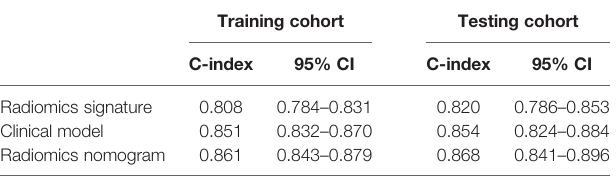
TABLE 2 | The C-index with 95% con fi dence intervals calculated for the training and validation cohorts. Training cohort